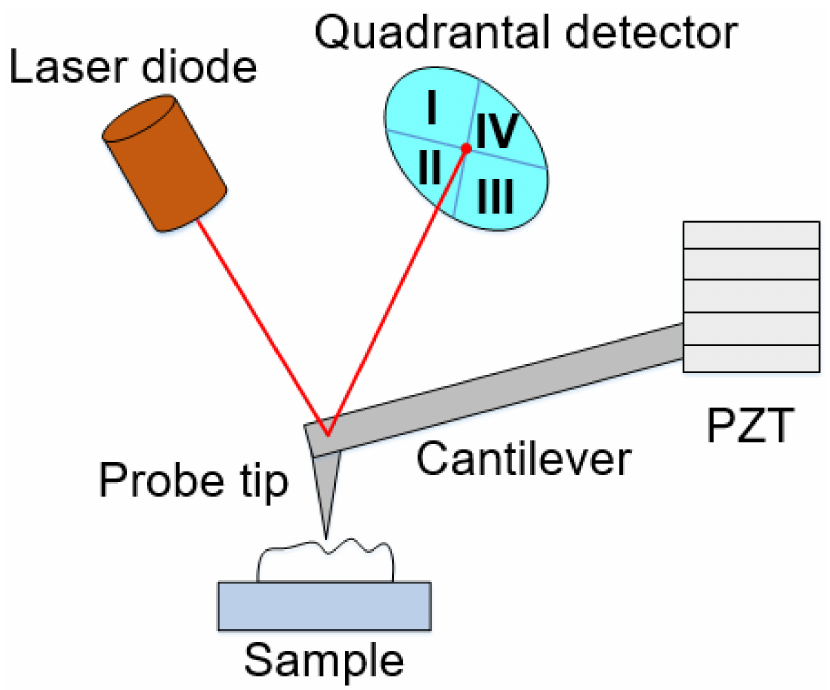
Figure 2. Schematic diagram of the scanning